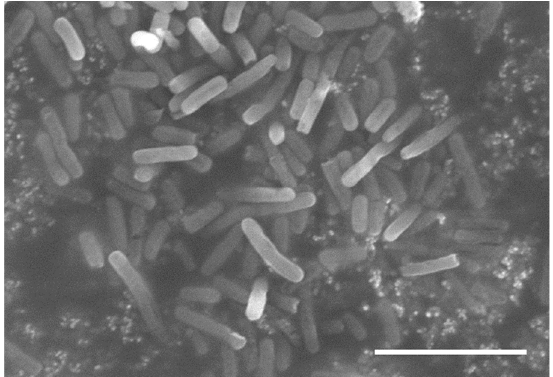
Figure 2. Morphological observation of strain GYP-74 cultured in de Man, Rogosa and Sharpe (MRS) medium with a scanning electron microscope (scale bar, 5 µm).